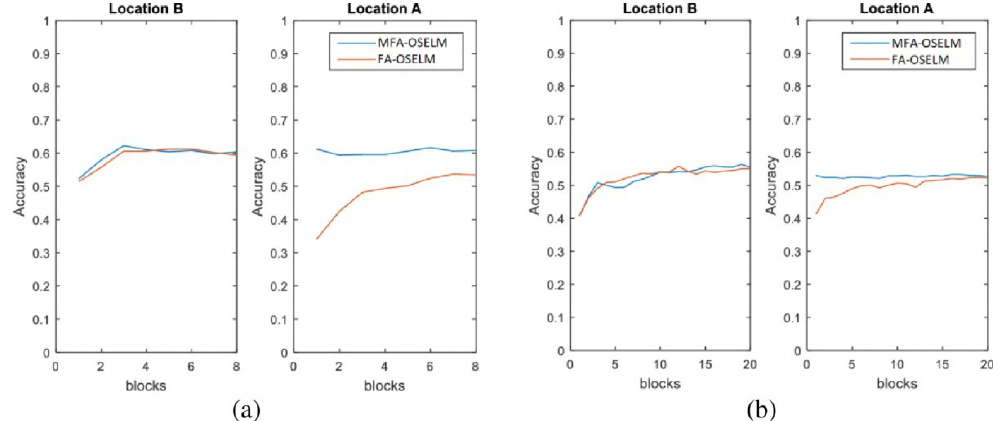
Figure 8. Scenario 4: The accuracy of MFA-OSELM and FA-OSELM for ( a ) the TampereU dataset and ( b ) the UJIIndoorLoc dataset.